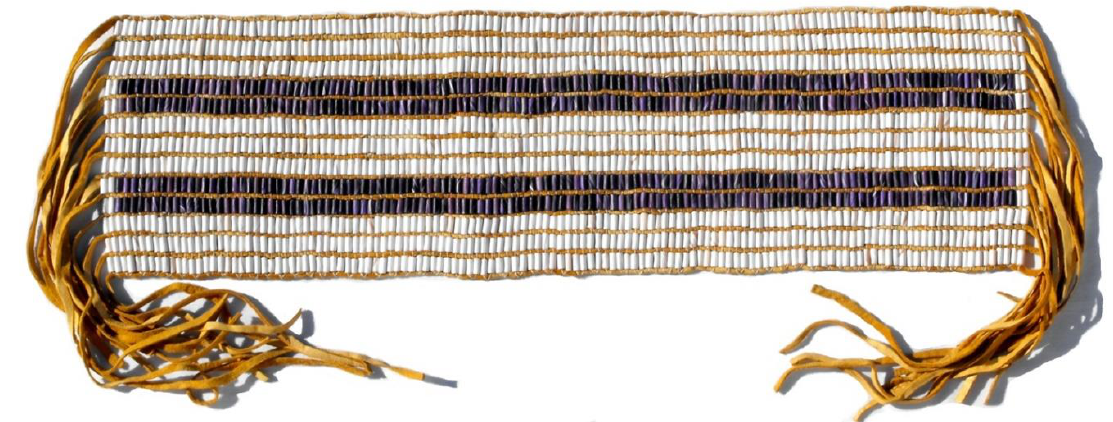
Figure 1: The wampum belt signifies “ that each nation will respect the ways of the other as they meet to discuss solutions to the issues that come before them ” (Onondaga Nation 2021). Courtesy: Darren Bonaparte who made the wampum replica above and to Tara Pringle-Block for making the beads Allyship and Decolonized